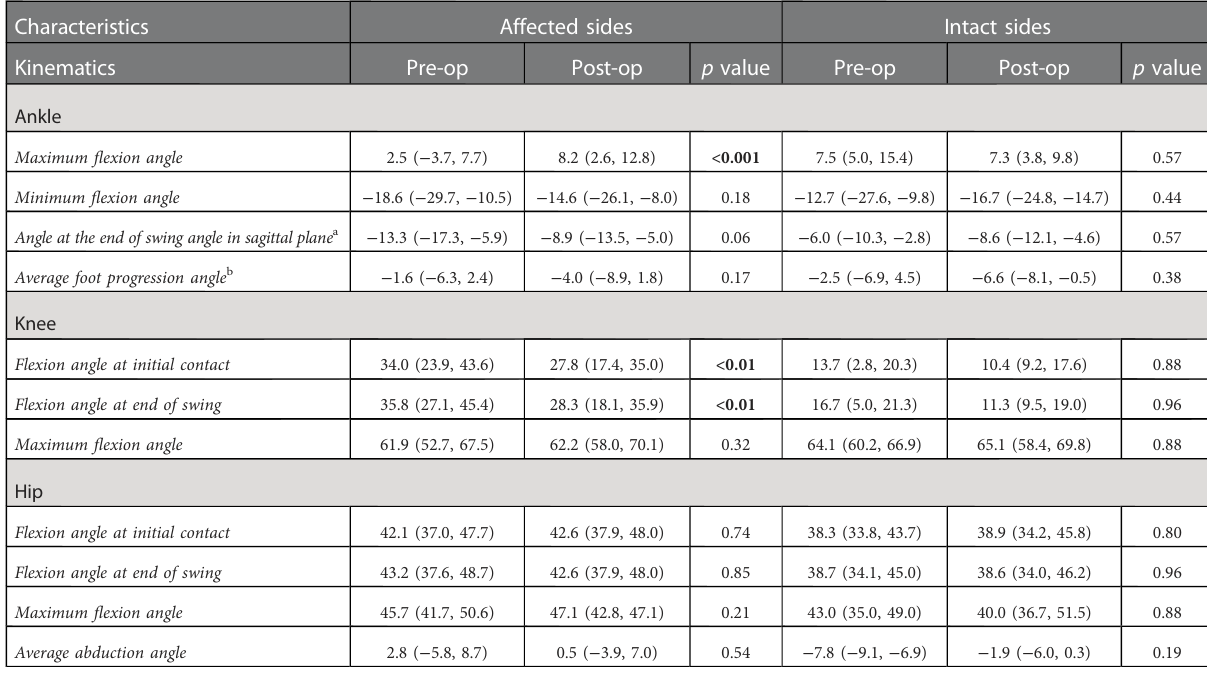
TABLE 3 Changes of extracted kinematic parameters in patients included in this study.